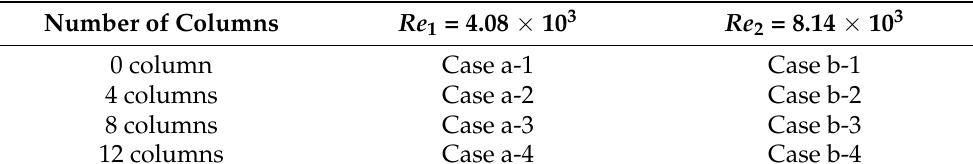
Table 8. Included test cases.